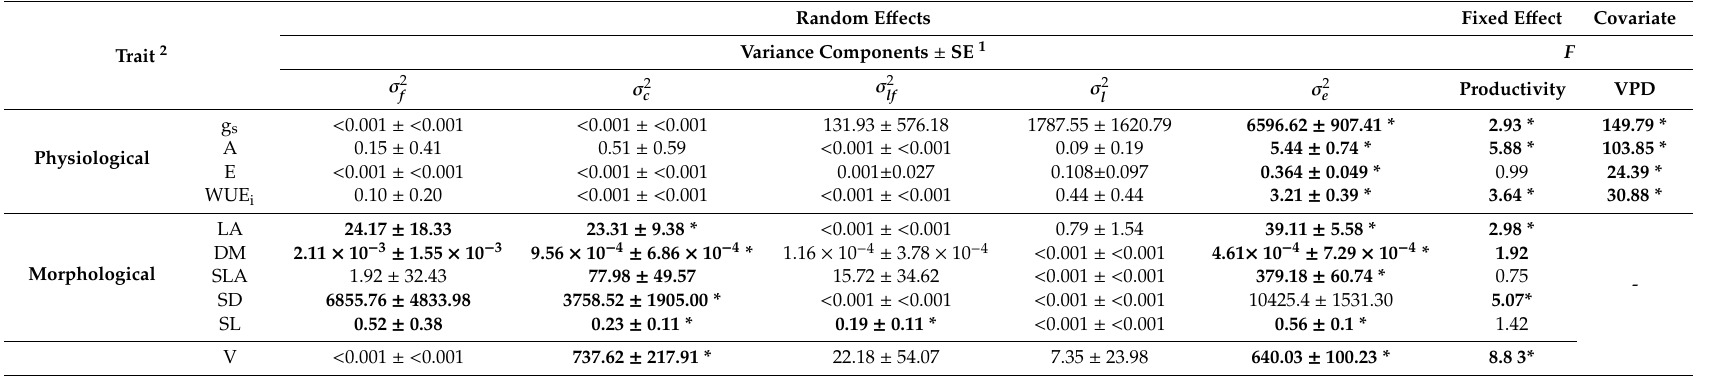
Table 4. Results of the linear mixed models for physiological and morphological traits. Variance components and their standard errors (SE) were estimated using the restricted maximum likelihood method. Level of significance of e ff ects is denoted by bolded values for 0.1 > p > 0.05, and bolded values accompanied with * for p < 0.05.